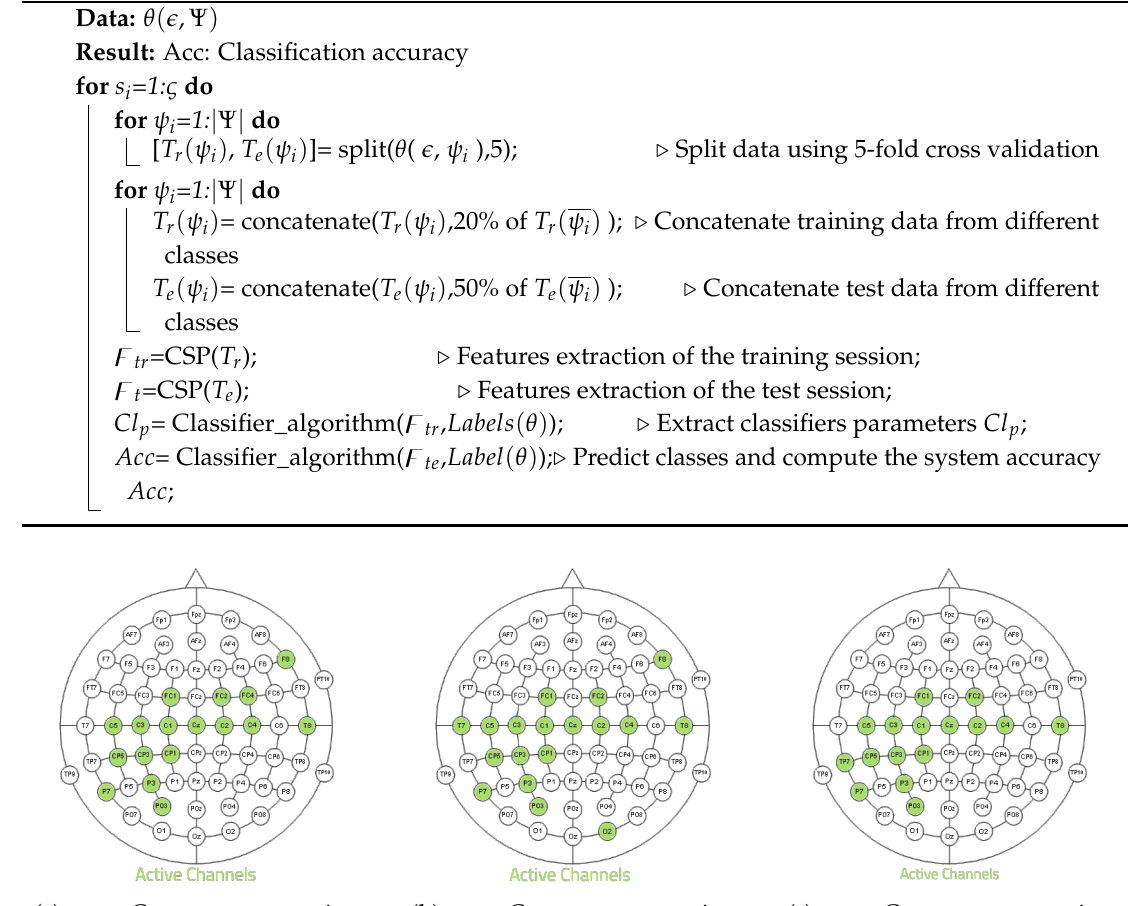
Algorithm 1: Commented algorithm of the basic steps of feature extraction and classification problems